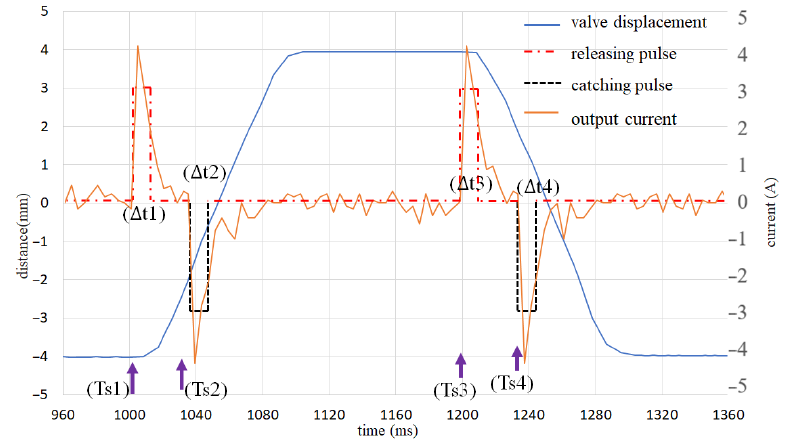
Appl. Sci. 2022 , 12 , x FOR PEER REVIEW Figure 12. Experimental test results for the proposed PMEM valve. Figure 12. Experimental test results for the proposed PMEM valve.